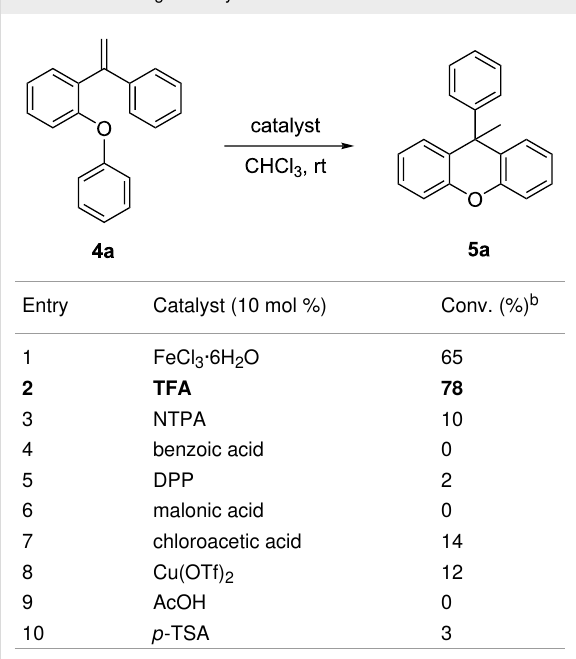
Table 1: Screening of catalysts for intramolecular FCA of 1a . a